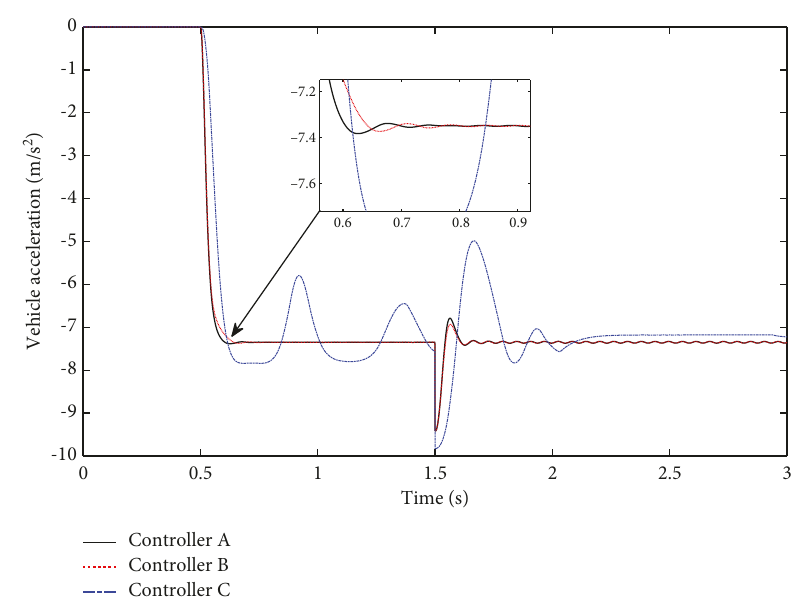
Figure 10: Vehicle acceleration.